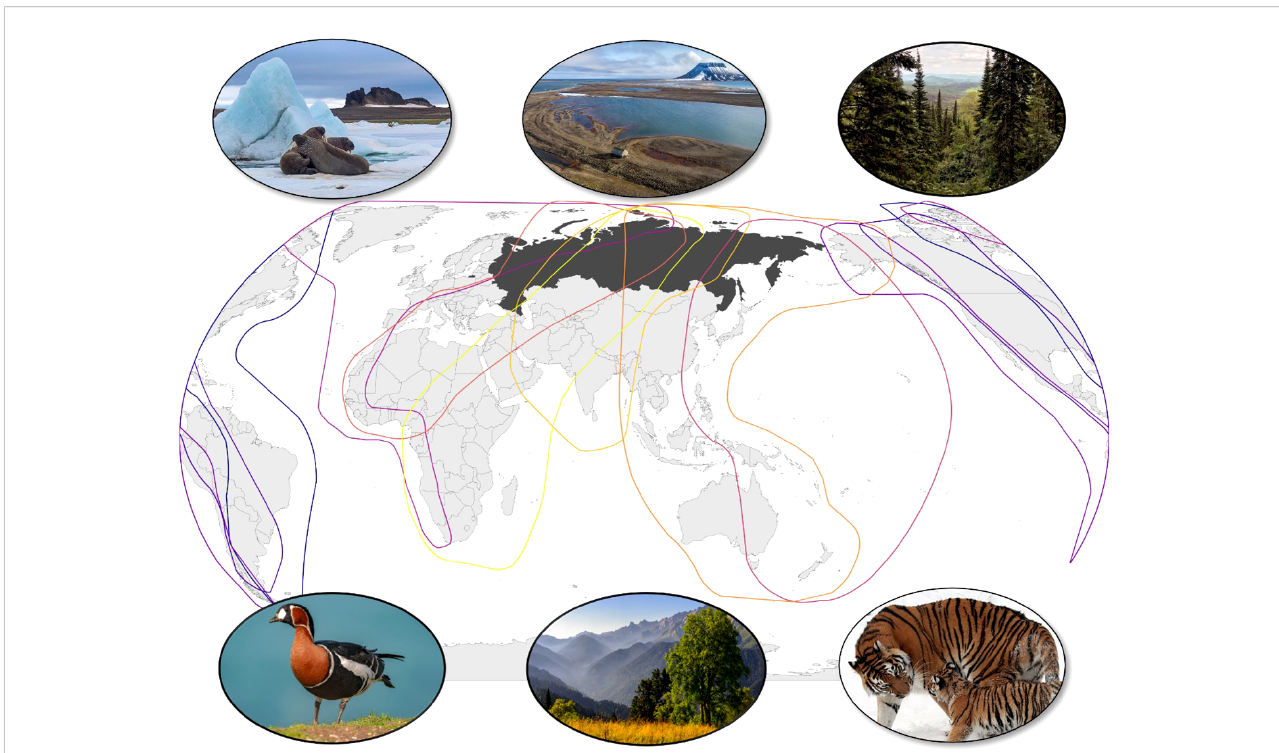
FIGURE 1 Depiction of the global importance of Russia for biodiversity conservation with select attributes. Map of global migratory waterbird fl yways intersecting Russia (shaded in dark grey; adapted from Wetlands International https://wpp.wetlands.org/downloads/downloads); Key features of biodiversity occurring in Russia [Top photos from left to right: walrus ( Odobenus rosmarus ; VU, IUCN Red List; photo credit: Николай Гернет , CC BY-SA 4.0), Russian Arctic National Park coastline (largest Arctic coastline within any country; photo credit: Timinilya, CC BY-SA 4.0), boreal forest (largest holding of this biome by any country; photo credit: Ruslan Gordeev, CC BY 3.0); bottom photos from left to right: Red-breasted goose ( Branta ru fi collis ; VU, IUCN Red List; photo credit: Vyacheslav Luzanov, CC BY-NC 4.0), Caucasus mountains (global biodiversity hotspot; photo credit: Илья Бунин , CC BY-SA 4.0), Amur tiger ( Panthera tigris altaica ; EN, IUCN Red List; photo credit: Dave Pape, public